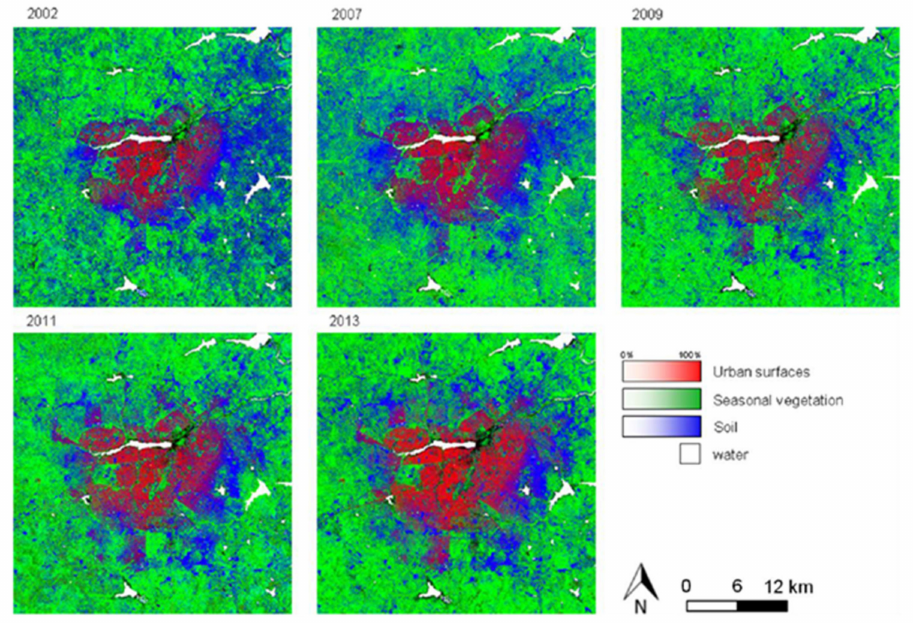
Figure 13. Fraction development of urban surfaces, seasonal vegetation and soil from 2002 to 2013. Source: [89].